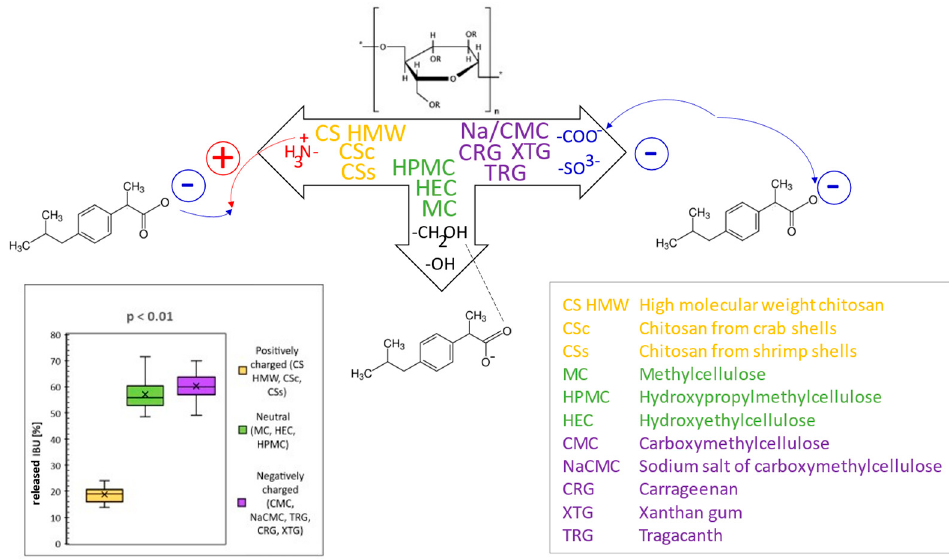
Figure 1. General scheme of interactions between different polysaccharides as hydrogel constituents and ibuprofen as model drug and resulting released amounts of ibuprofen from different polysaccharide hydrogels.